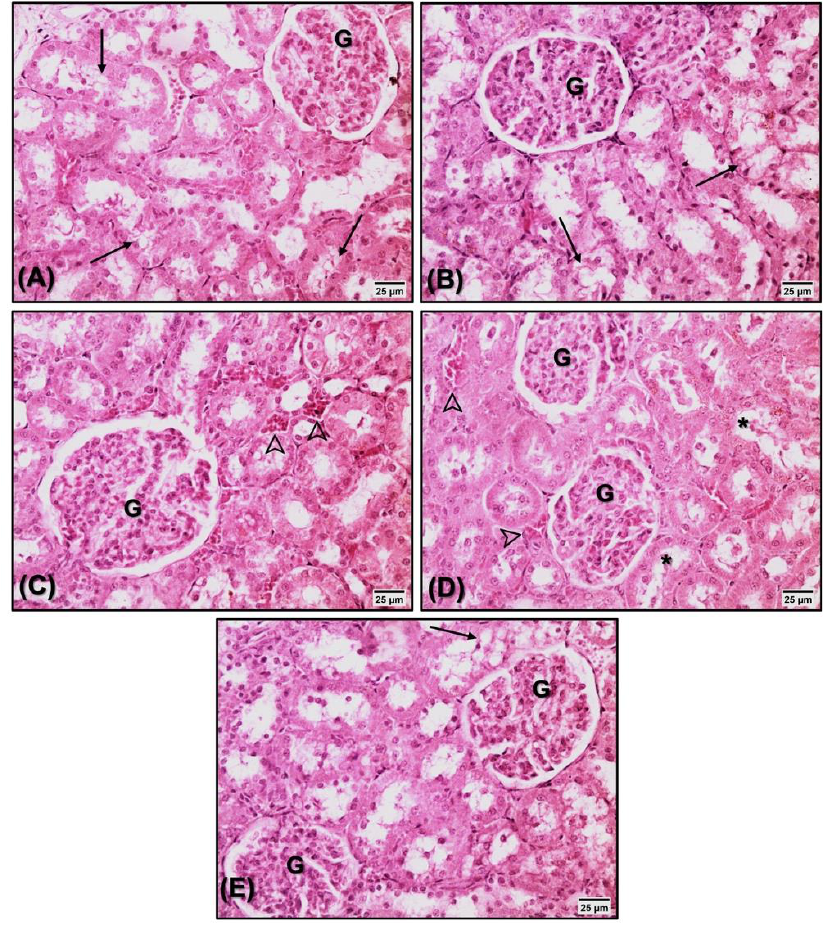
Figure 6. Kidney histopathology (HE, 40 × ) of animals treated with saline ( A ), estrogen ( B ), flaxseed extract ( C ), mulberry extract ( D ), and flaxseed + mulberry ( E ). Mild morphological alterations, such as tubular vacuolization (arrows), vascular congestion (arrowheads), and tubular dilatation (*). No significant differences were observed between the groups. G: